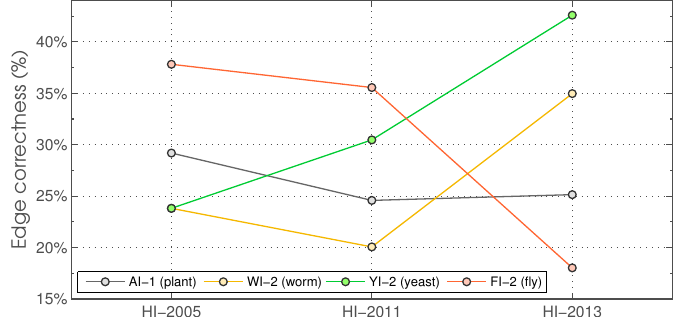
Figure 6: Alignment between human and non-human PPI networks. The y -axis shows the per- centage of aligned interactions (edges) between PPI networks (numbers of correctly aligned inter- actions are given in Table 2). Table 2: Alignment between human PPI networks and PPI networks of A. thaliana , C. elegans , S. cerevisiae and D. melanogaster : edge correctness values are given as percentages with